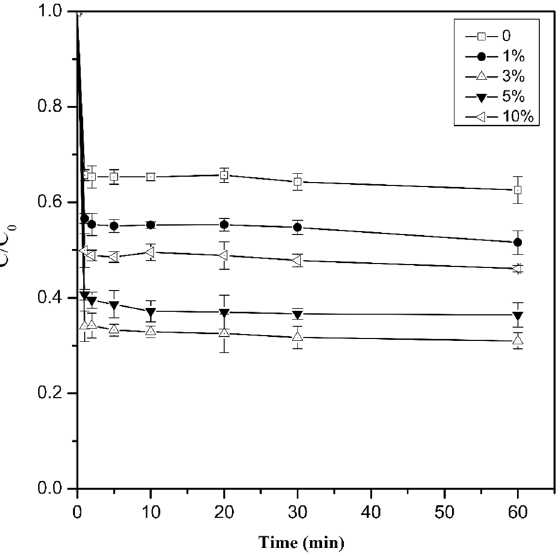
Figure 3. Effect of copper loading rates on Cr(VI) removal by Cu/Fe bimetallic nanoparticles. Error bars indicate the standard deviation of the mean (n =